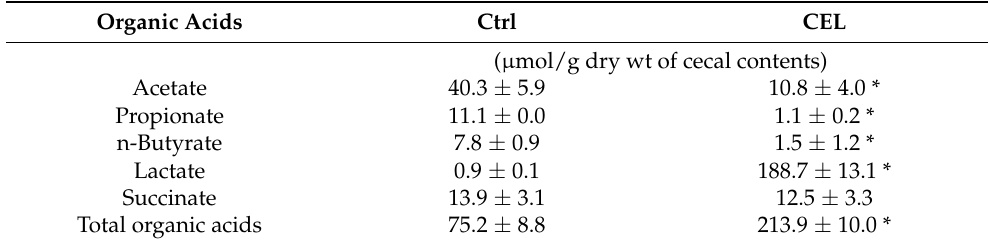
Table 2. Effects of supplemental CEL on the levels of organic acids in cecum of rats.